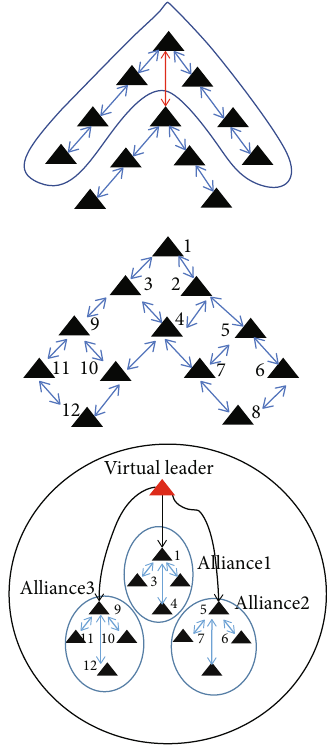
Figure 1: Formation structure based on the diamond and V